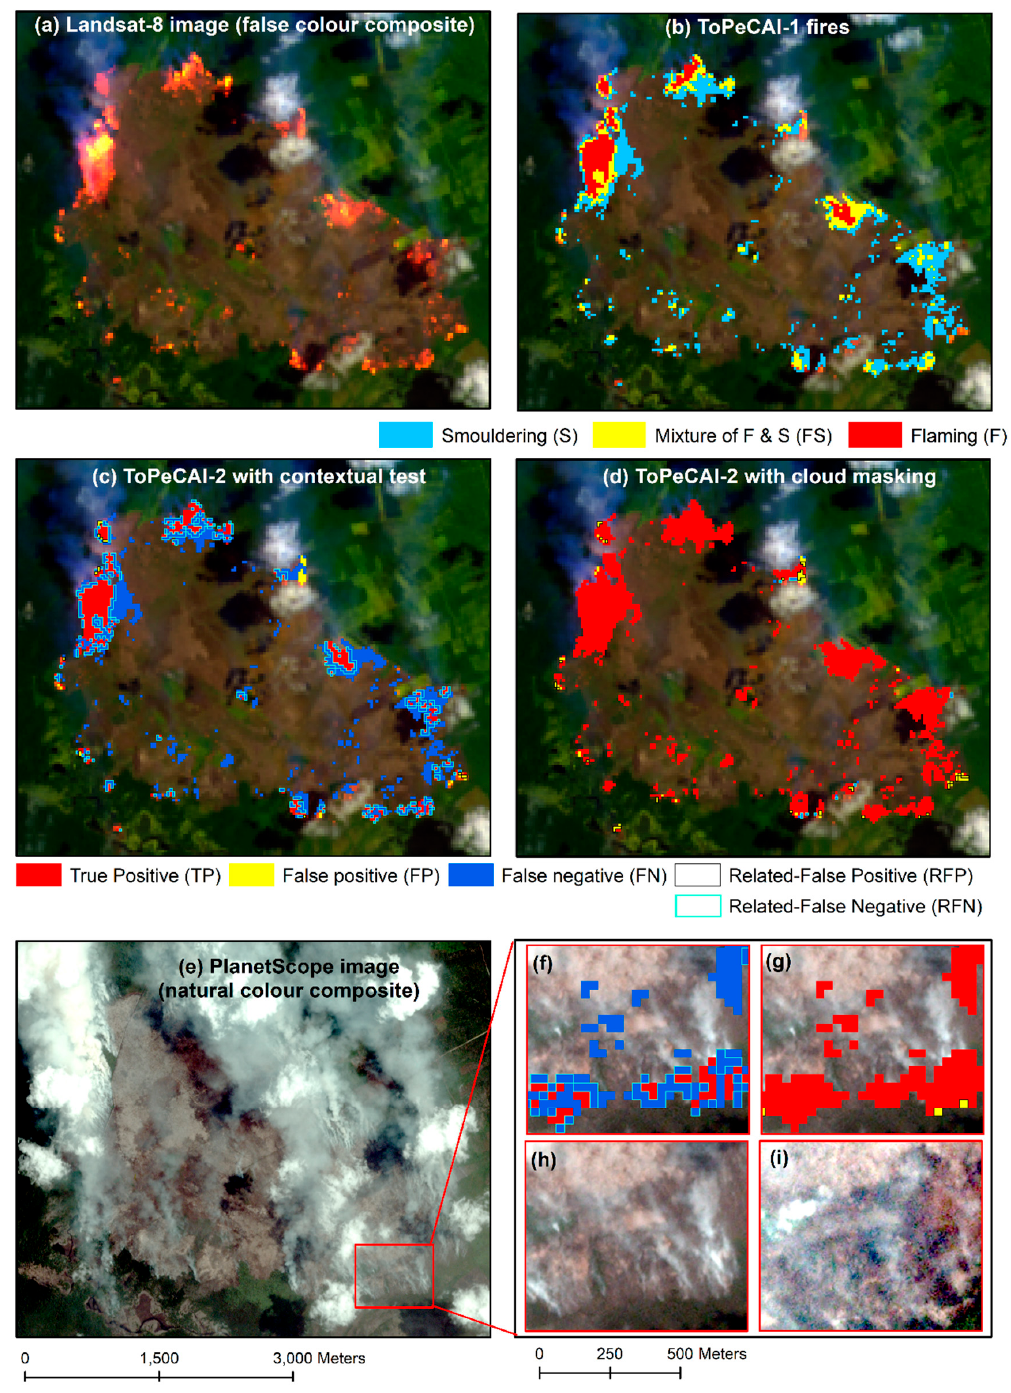
Figure 10. ( a ) RGB image of Landsat-8 OLI with SWIR-2 band as Red layer, SWIR-1 band as Green layer, and Red band as Blue layer. Landsat-8 image was acquired on 29 August 2019 over Riau’s peatland; ( b ) ToPeCAl-1 fires overlaid on the same RGB image of Landsat-8 in Figure ( a ); ( c ) Result of ToPeCAl-2 fires with contextual test compared with ToPeCAl-1 fires from the same Landsat-8 image of Figure ( a ); ( d ) Comparison result of ToPeCAl-2 with cloud masking. TP is the true positive fire pixel; FP is the false positive fire pixel; FN is the false negative fire pixel. The RFP or RFN is the spatially related of false positive/false negative pixels which adjacent to TP pixel and existed within one pixel buffer from the TP pixel; ( e ) Natural RGB image of PlanetScope in the same area of Landsat- 8 image and the same day about 11 min before Landsat-8 acquisition on 29 August 2019; ( f , g ) An